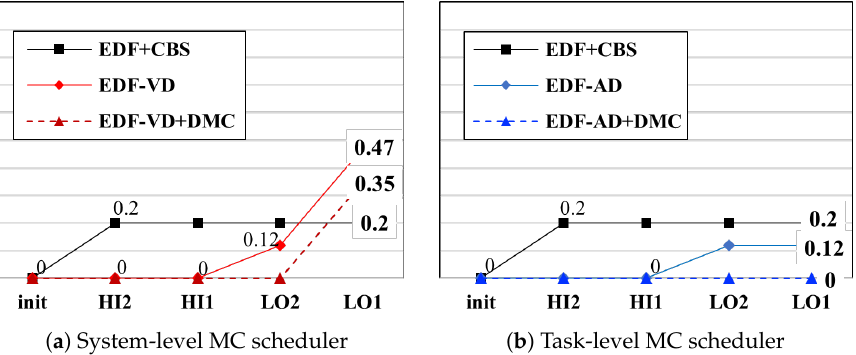
Figure 7. Accumulative result of mode-switch-triggered DMR test on ( a ) system-level and ( b ) task- level MC schedulers under task-level scheduling